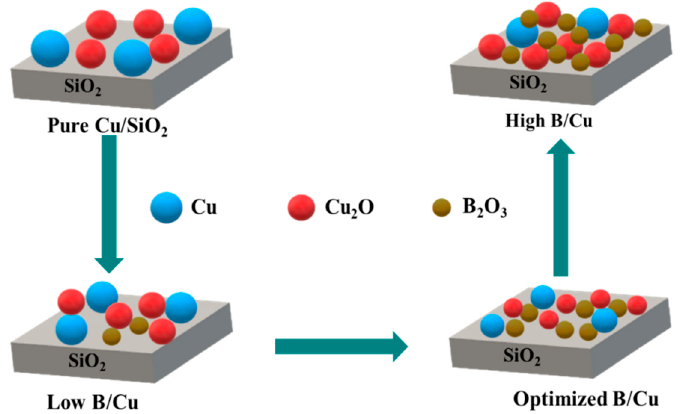
Figure 9. Schematic diagram of x B-Cu/SiO 2 catalysts with the increase of B/Cu molar ratio.